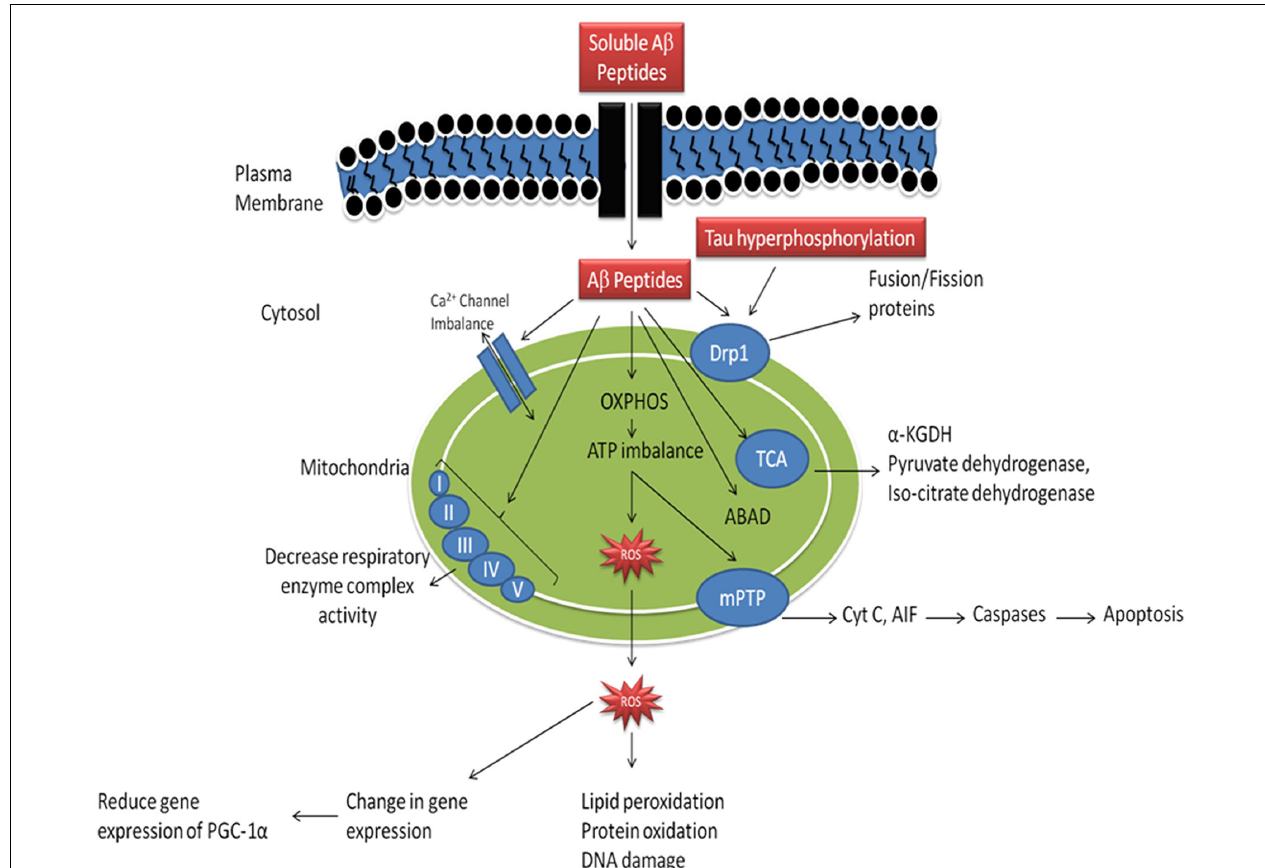
FIGURE 1 | Mechanism of mitochondrial dysfunction in Alzheimer’s disease. (A b -amyloid b , OXPHOS- oxidative phosphorylation, ROS- reative oxygen species, mPTP- mitochondrial permeability transition pore, Cyt C- cytochrome C, Drp1- dynamin—related protein-1, ABAD- amyloid b binding alcohol dehydrogenase, a -KGDH- a -ketoglutarate dehydrogenase complex, PGC-1 a - peroxisome proliferator activated receptor- g -coactivator-1- a ). Adopted and modified from Reddy and Beal (2008). 2011). Accumulation of soluble A b peptide and mutant